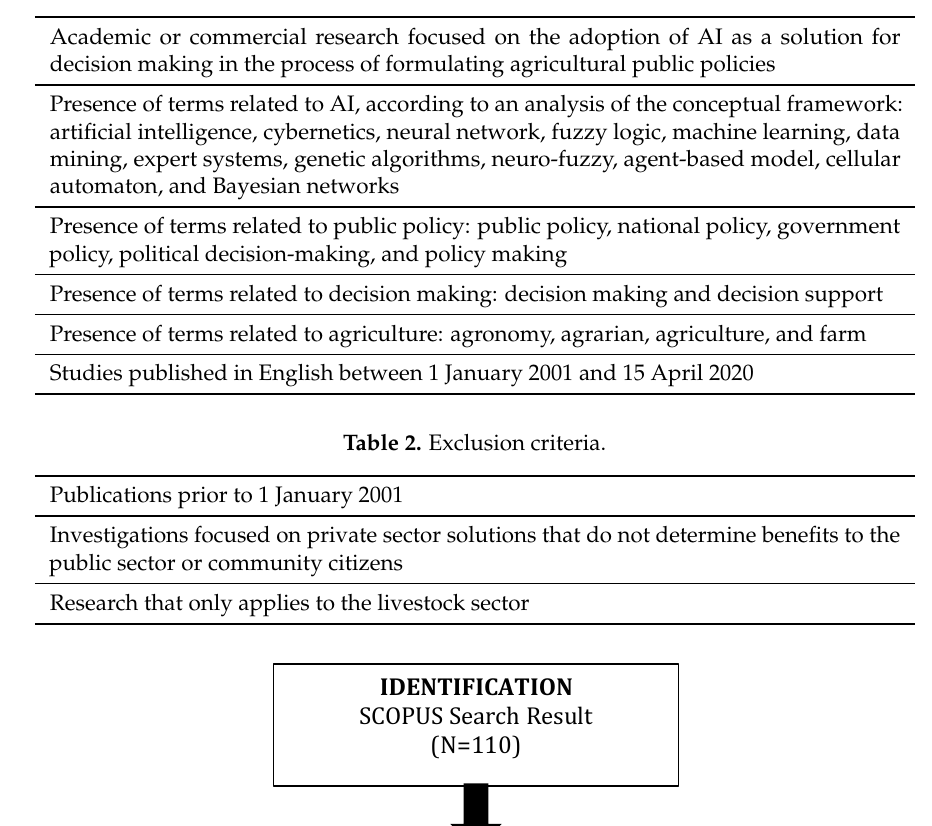
Table 1. Inclusion criteria.